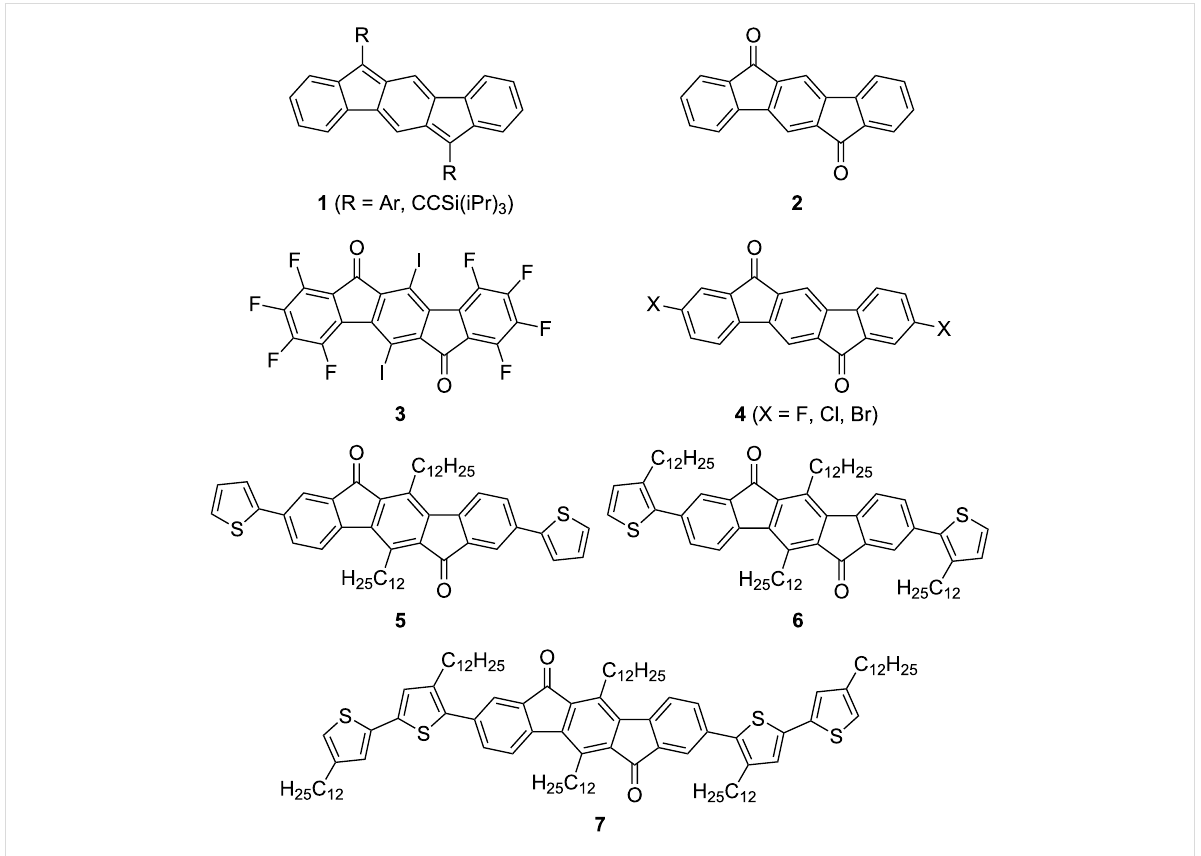
Figure 1: Previously reported indeno[1,2- b ]fluorenes and related indeno[1,2- b